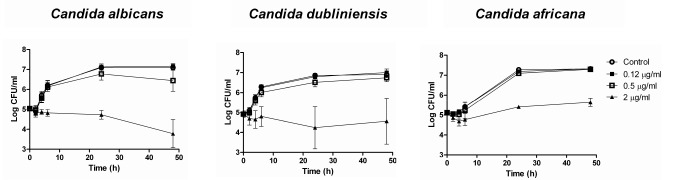
Mean TK curves from PAFE assays against 7 C. albicans, 5 C. dubliniensis and 2 C. africana strains.Each data point represents the mean result ± standard deviation (error bars). Open circles (○): control; filled squares (■): 0.12 μg/ml; open squares (□): 0.5 μg/ml; filled triangles (▲): 2 μg/ml.